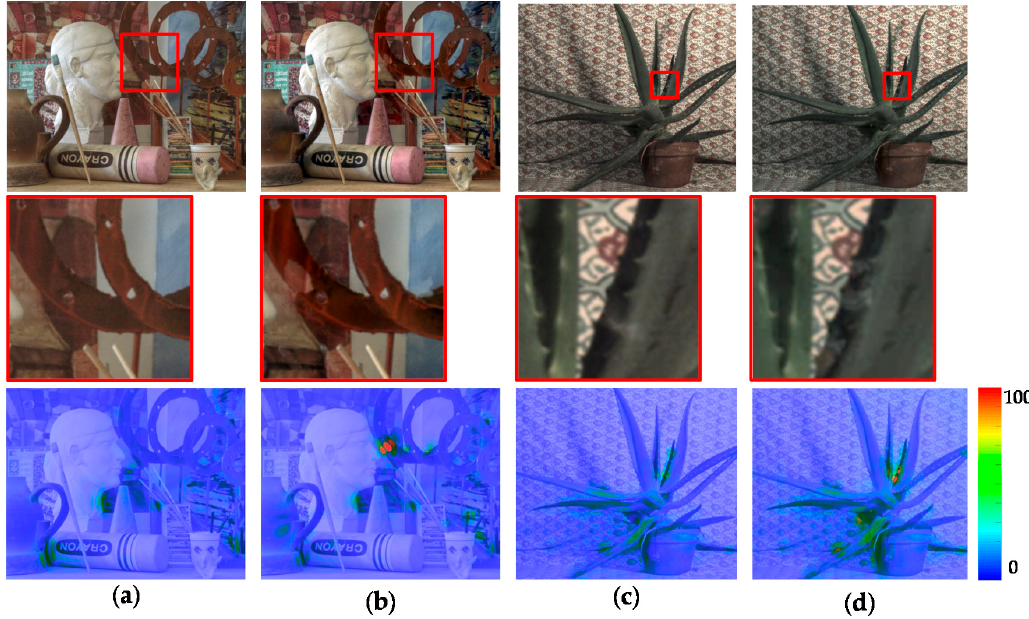
Figure 22. Resultant LDR images (first row) and their magnified sub-regions (second row) obtained with or without the proposed rejection step: ( a , c ) with the proposed rejection step; and ( b , d ) without the proposed rejection method. Color-coded HDR-VDP2 maps (last row) are provided for a better performance comparison.